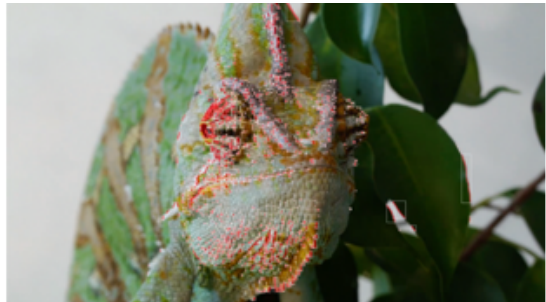
Figure 9 | Isolating and visualizing motion or state changes